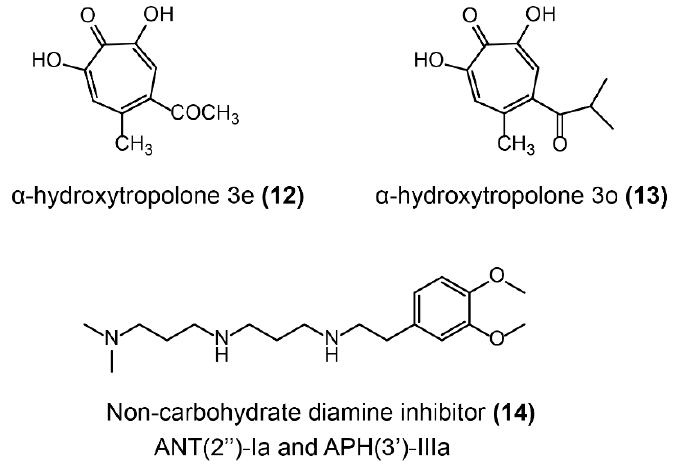
Figure 11. Inhibitors of aminoglycoside ANTs.